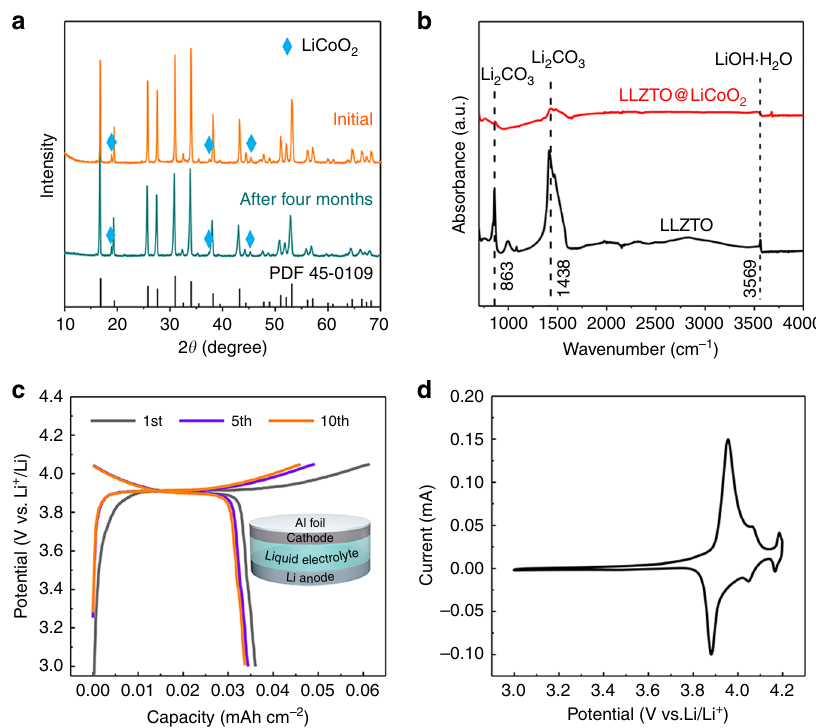
Fig. 3 Stability and activity test of LLZTO@LCO. a XRD patterns of LLZTO@LCO before and after exposure to air for four months. b FTIR spectra of the LLZTO and LLZTO@LCO samples after exposure to air for four months. c , d Charge/Discharge curves and cyclic voltammetry pro fi le of the liquid cells. The inset in Fig. 3c shows the structural illustration of the cell, in which the cathode was prepared by mixing LLZTO@LCO, PVDF and